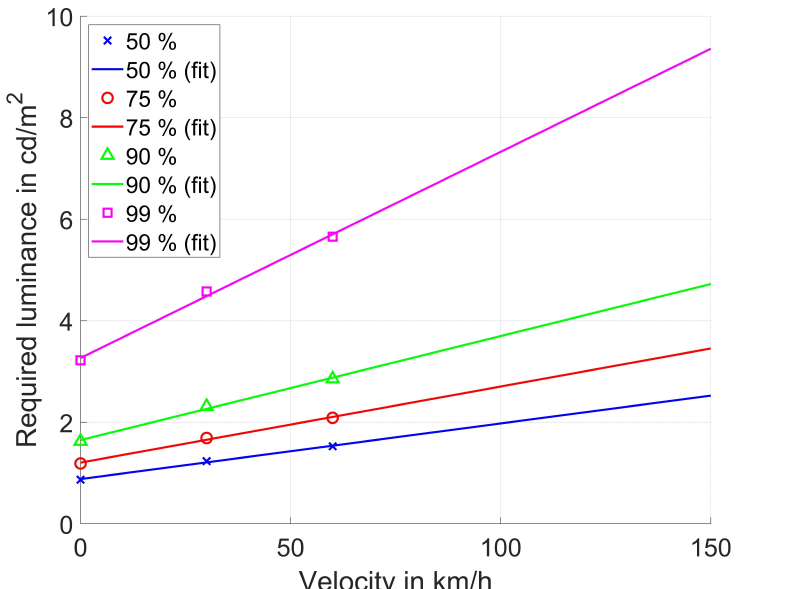
Figure 10. Speed dependence of the average road surface luminance required for achieving the indicated probability levels of a “bright” or better rating. By linear regression, the behavior of the road surface luminance can be interpolated or extrapolated to estimate required luminance values for arbitrary velocities enabling an adaptive headlamp design.